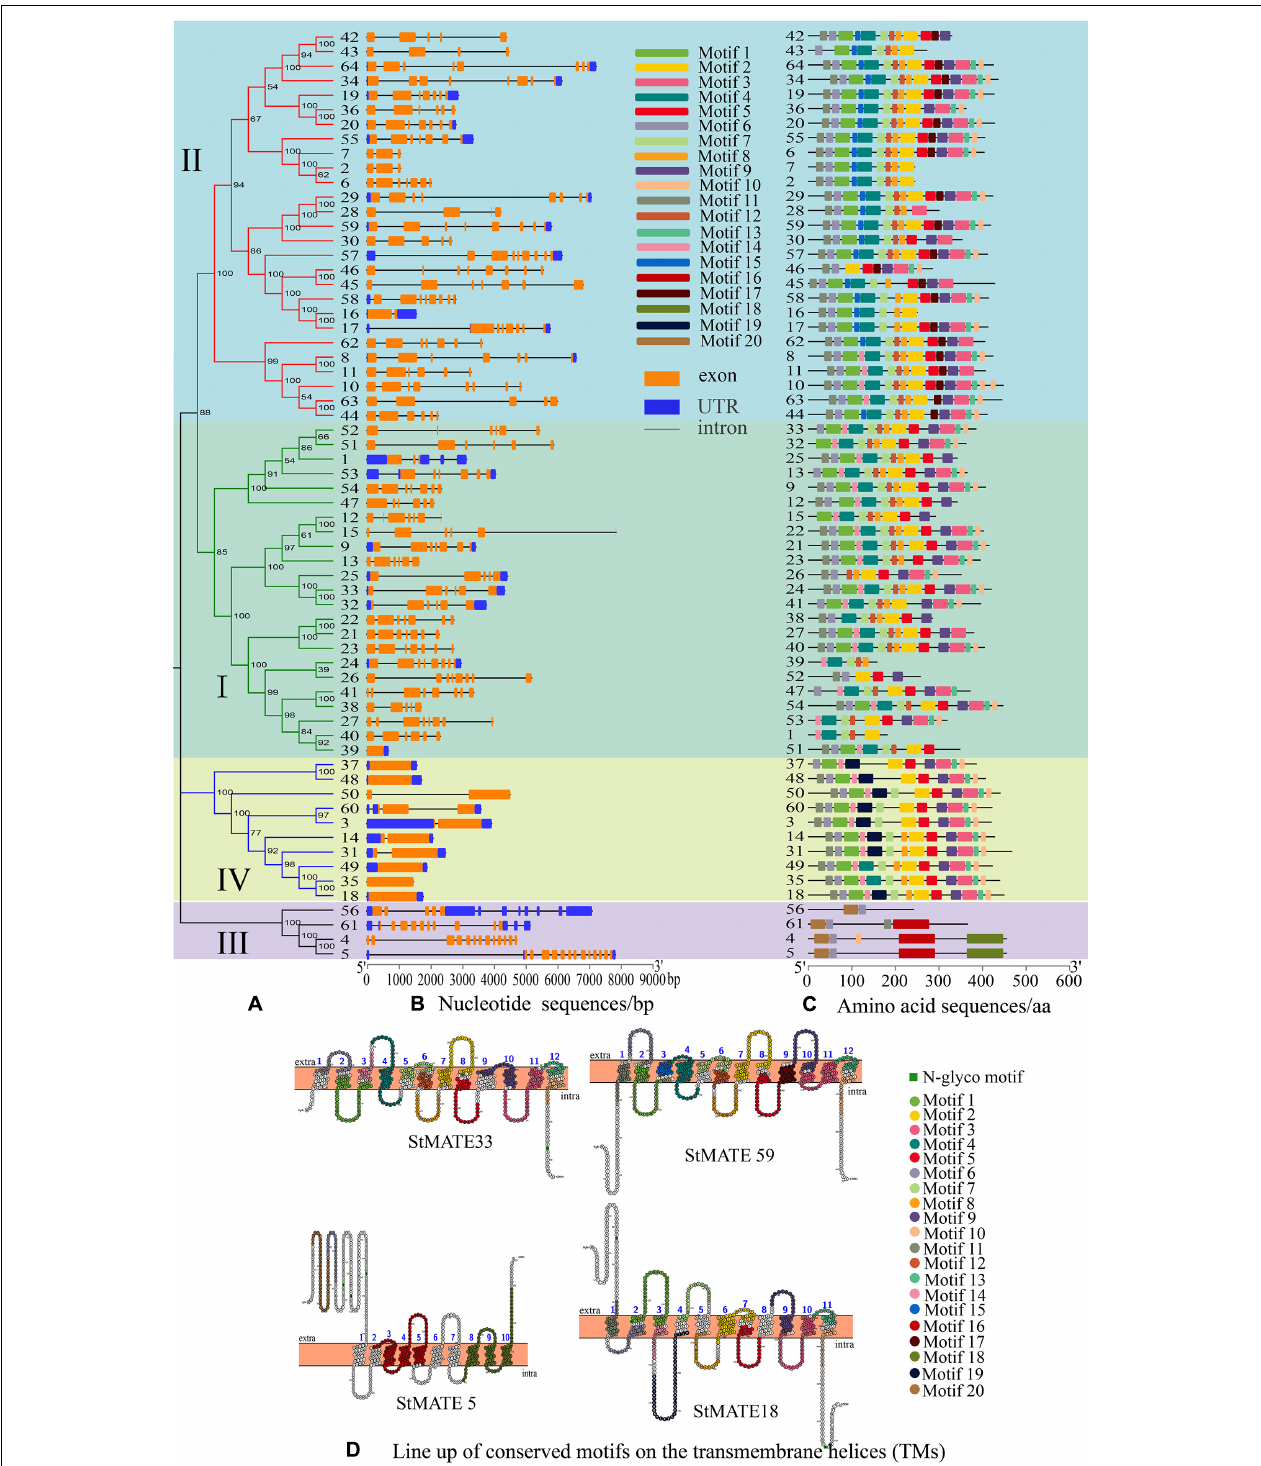
FIGURE 5 | Analysis of motifs, transmembrane helices (TMs), and exon–intron structure of StMATE genes. The numbers 1–64 represent StMATE1 – StMATE64 . (A) Phylogenetic tree, the various subfamilies were numbered I, II, III, and IV. (B) Gene structures of StMATE genes, orange boxes, blue boxes, and lines represented exon, untranslated region (UTR), and introns, respectively. The lengths of the boxes and lines were scaled according to the gene length. (C) All motifs were identified by MEME (v4.12.0) according to the complete amino acid sequences. (D) Lineup of conserved motifs on the TMs. The transmembrane structure is marked with blue numbers, the conserved motif is indicated in different colors, and its related information is on the